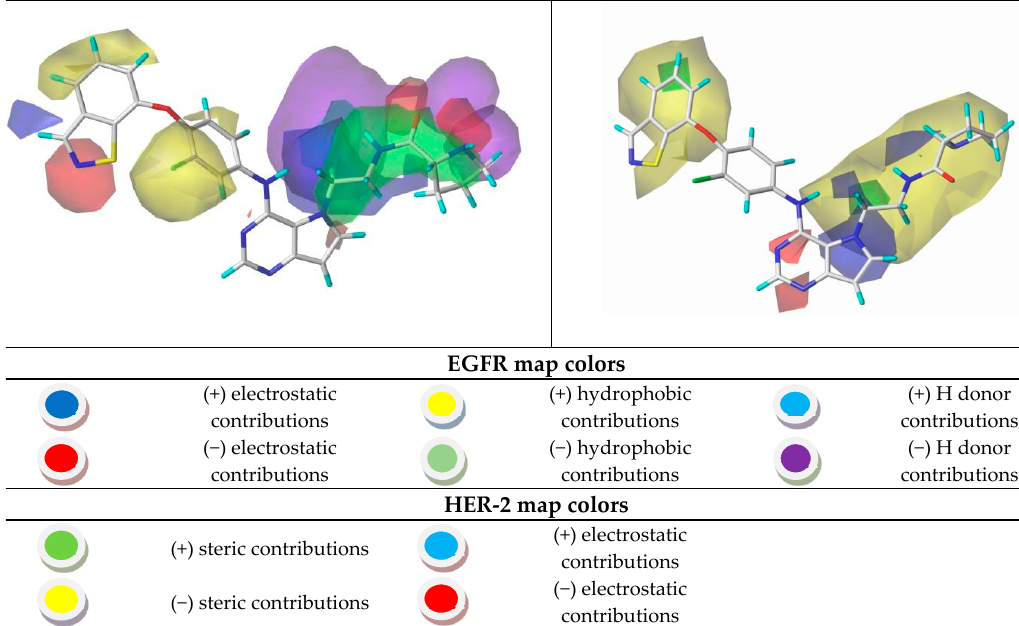
Figure 7. CoMSIA contour maps for the most and the least active compounds (EGFR and HER-2).